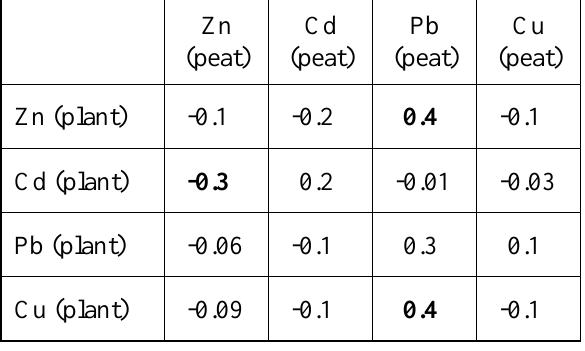
Table 5. Spearman Rank Order Correlations of the elemental content of plant and peat dry matter. Bold